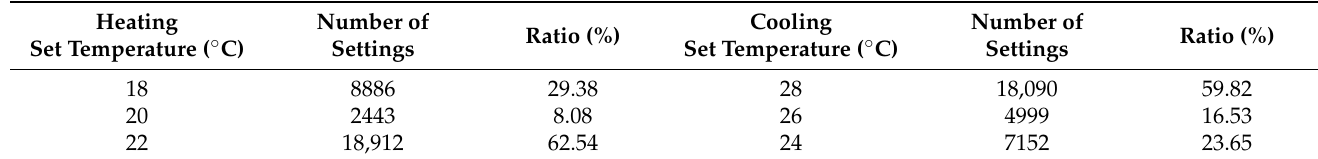
Table 10. Number and ratio of set temperature in Case